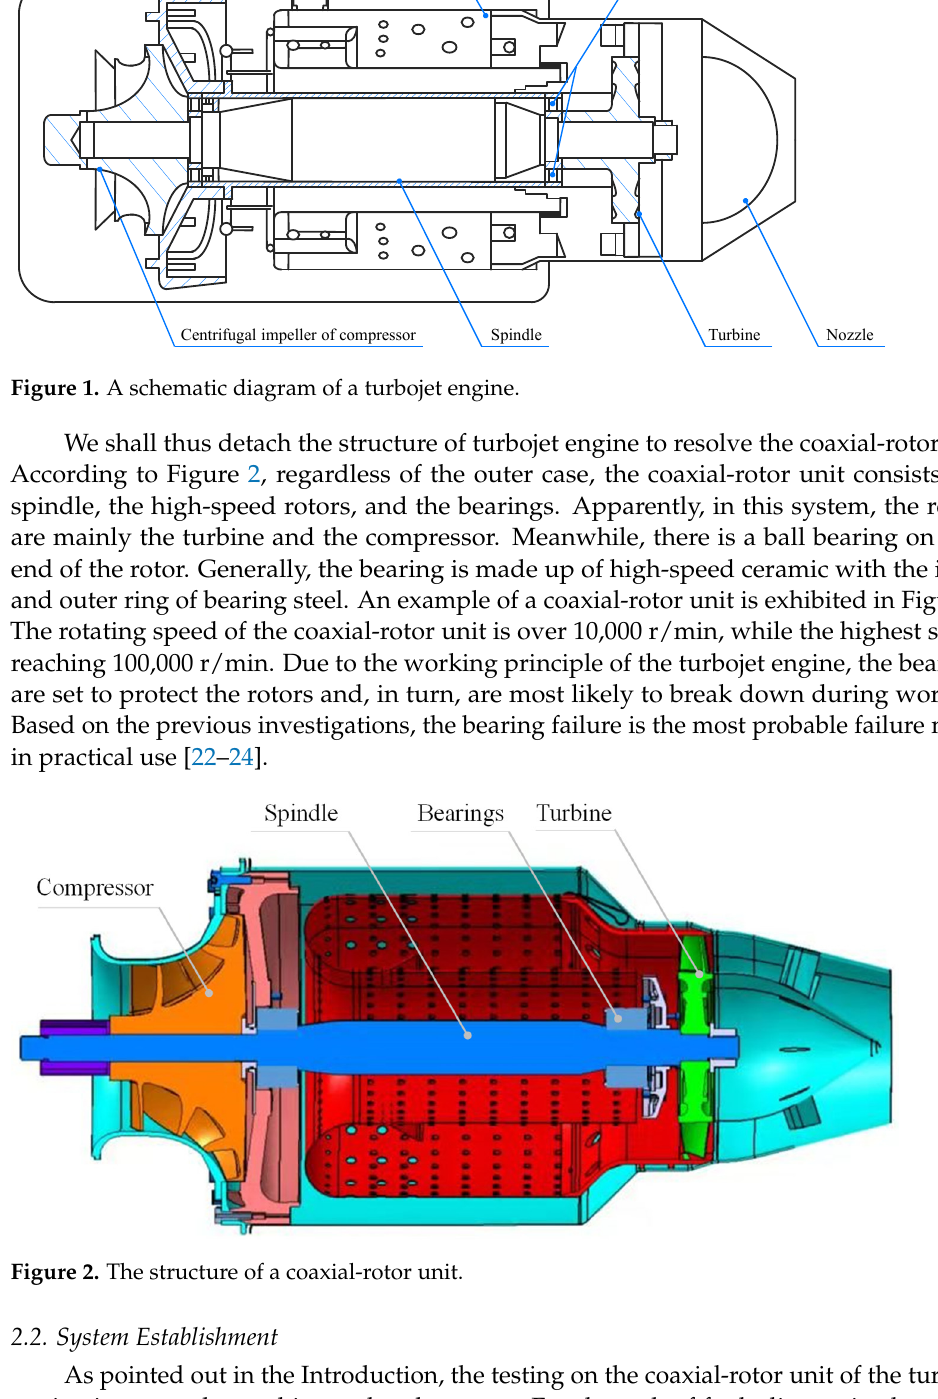
Figure 2. The structure of a coaxial-rotor unit.